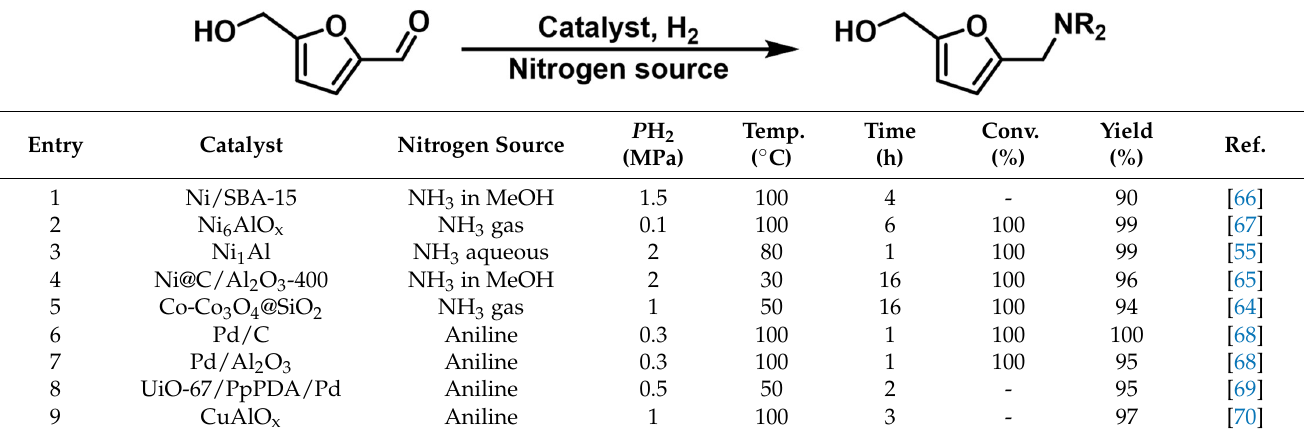
Table 2. Reductive amination of HMF with different nitrogen sources.